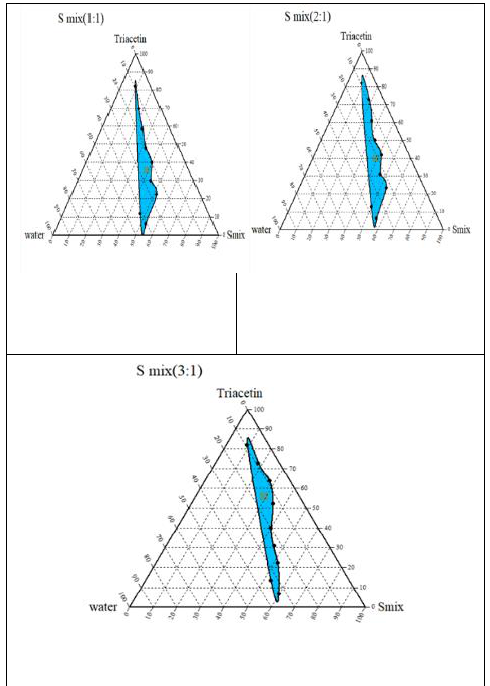
Figure 3. Pseudo-ternary phase diagrams showing the (o/w) nanoemulsion (colored area) regions of triacetin oil (oil), tween 80 and cremophore EL (1:3) ratio (surfactant mixture), tetraglycol (co-surfactant) at different Smix ratios (1:1, 2:1, and 3:1) at 25 °C.